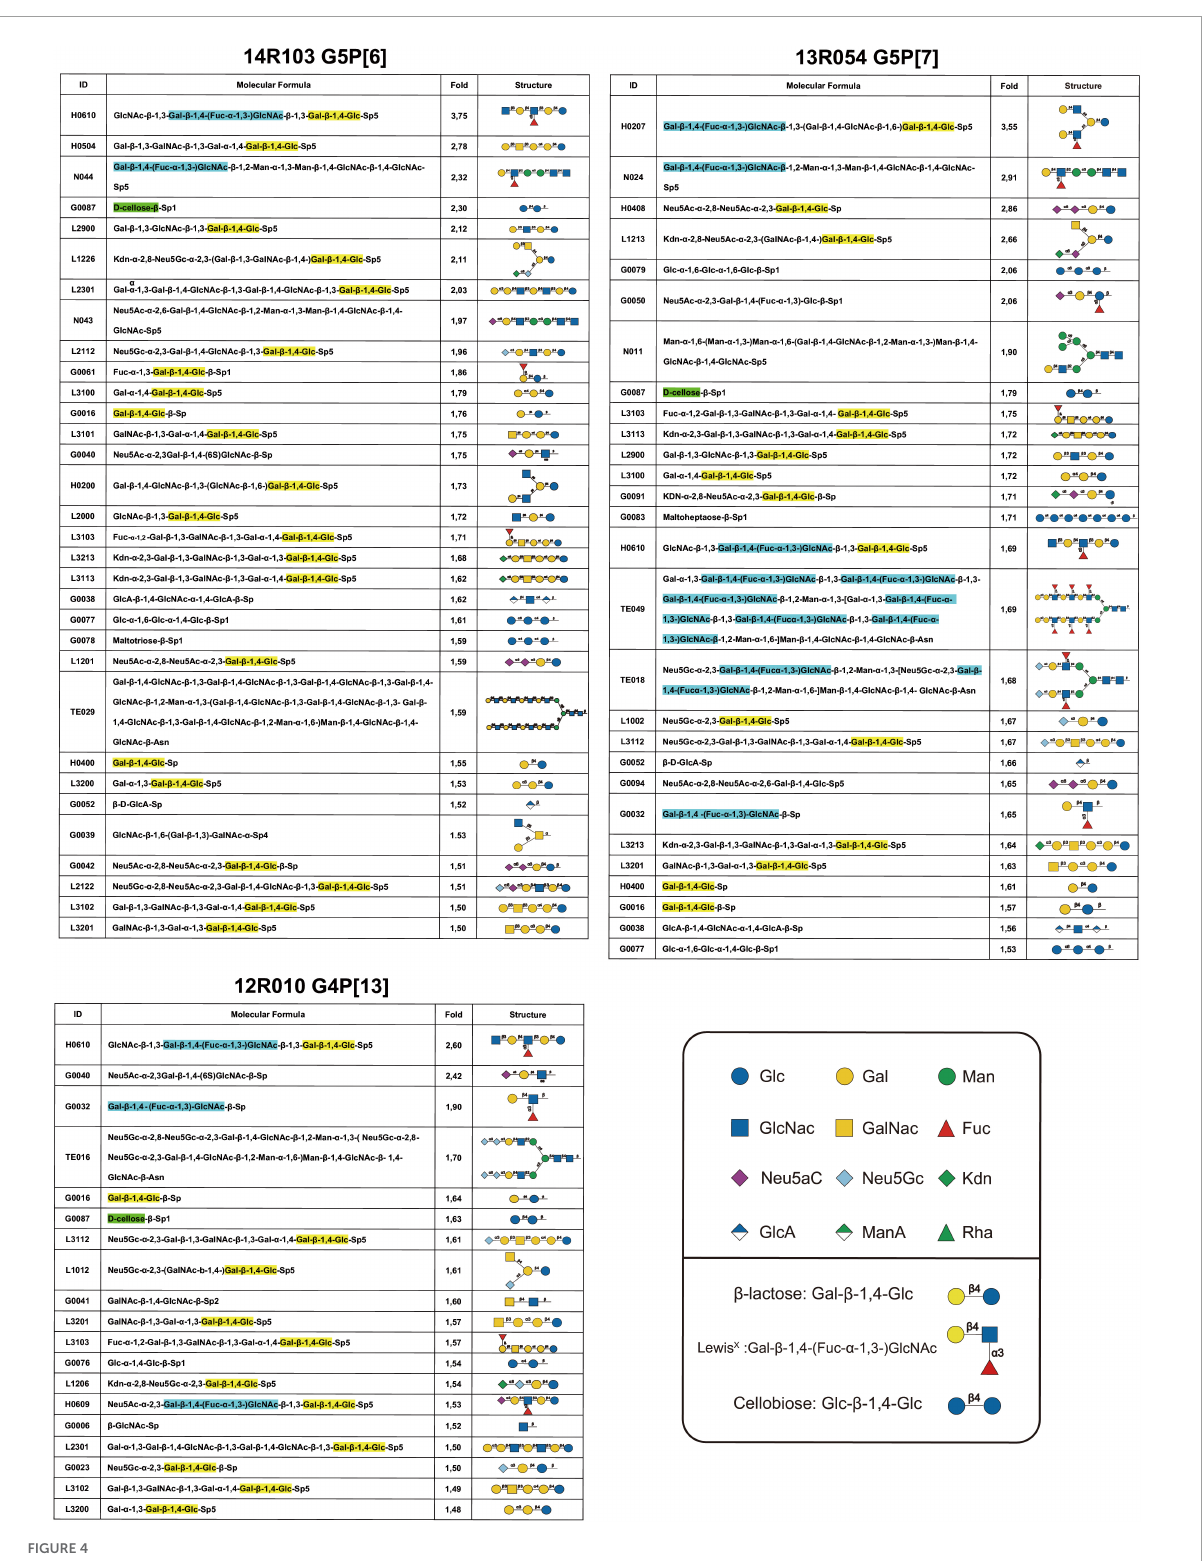
FIGURE4 Glycan array results of VP8 ∗ proteins from porcine RVA strains 14R103 (G5P[6]), 13R054 (G5P[7]) and 12R010 (G4P[13]). The glycans from an array library containing 300 glycans, that are recognized by each VP8 ∗ , were ranked following the binding strength. The values are the fold increase of the fluorescence signal compared to that of GST (negative control). The β -lactose monomer was marked in yellow, the Lewis X monomer was marked in blue, and the cellobiose monomer was marked in